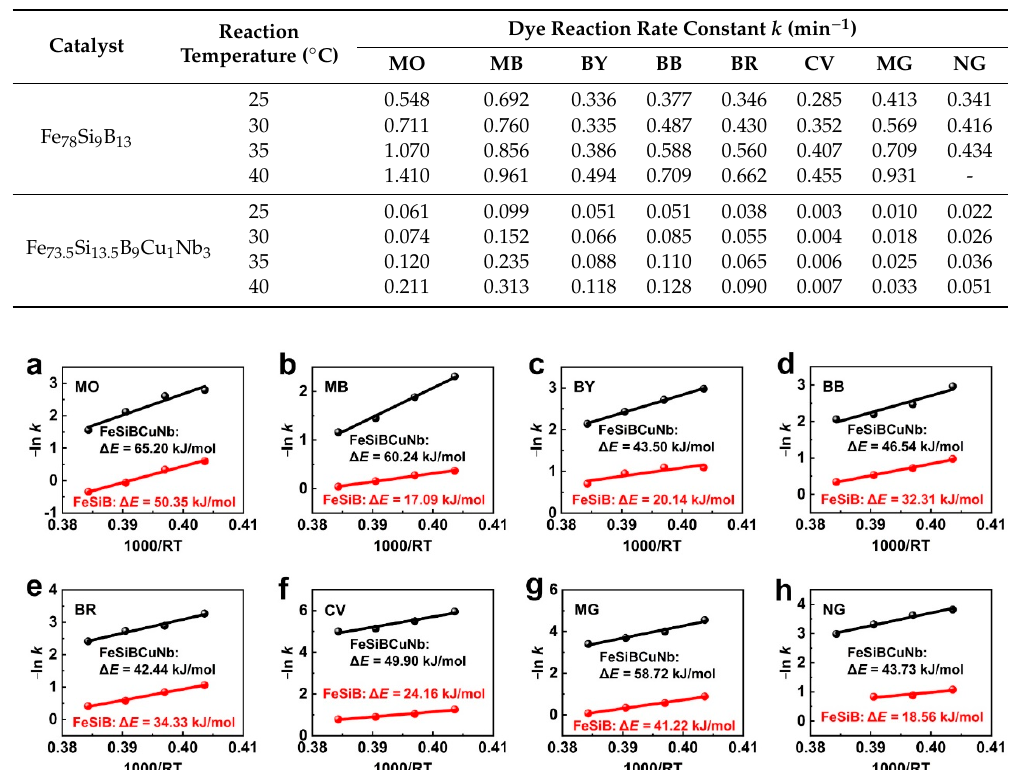
Table 2. Reaction rate constants ( k ) of dye degradation by Fe 78 Si 9 B 13 and Fe 73.5 Si 13.5 B 9 Cu 1 Nb 3 metallic glass ribbons under different reaction temperatures. All the k values were obtained from Figures 2 and 3 with fixed catalyst dosage (0.5 g/L).